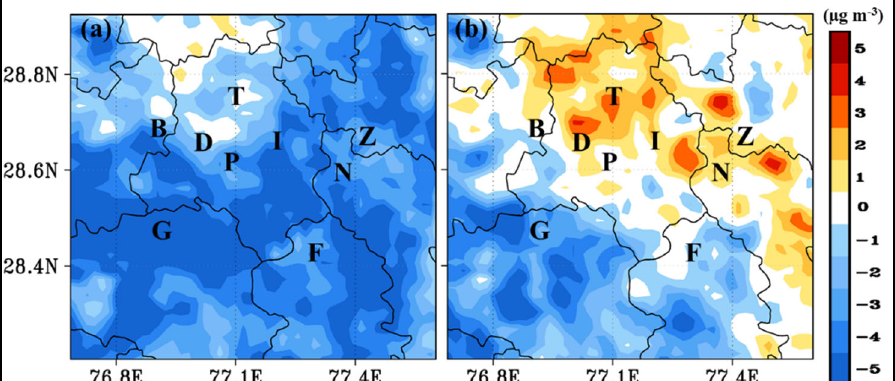
Figure 7. Spatial plots of ( a ) difference of ozone concentrations ( μ g m − 3 ) between case with direct feedback and no feedback (Case B—Case A) and ( b ) difference of ozone concentrations ( μ g m − 3) between case with direct and indirect feedback and no feedback (Case C—Case A) over NCT. (P: Punjabi Bagh, D: Dwarka, I: ITO, T: DTU, N: Noida, Z: Ghaziabad, F: Faridabad, G: Gurugram and B: Bahadurgarh).